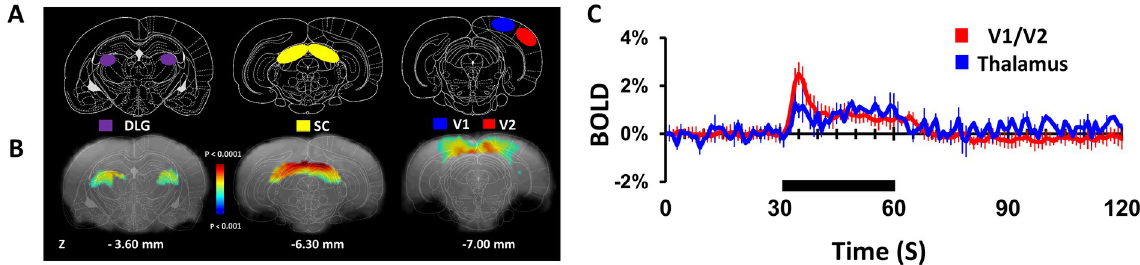
Fig 3. Visual stimulation-induced activation of rat visual cortex and thalamus revealed by high-field (11.7T) fMRI (8 rats, 21 trials). Significant BOLD activations were observed at the primary and secondary visual cortices (V1/V2), superior colliculus (SC) and thalamic activations were mainly found in dorsal parts of the lateral geniculate nucleus (DLG) during bilateral eye stimulation (1Hz, 50 ms, Blue light). BOLD activation maps, displayed as colored statistical maps (a 2-sample, unpaired, T-test with equal variance and one tail for stimulation (30s) > baseline (30s)) overlaid on the corresponding anatomical images. A and B represents coronal slices corresponding to visual cortices, superior colliculus (SC) and dorsal lateral geniculate nucleus (DLG) of the thalamus positioned at 7.0 mm posterior to bregma for V1/V2, 6.30 and 3.60 mm posterior to bregma for SC and DLG regions. To correlate activations in cortical and thalamic regions, reference stereotaxic atlas images were overlaid on the corresponding anatomical images. C represents the mean ± SD time course of BOLD activations at V1/V2 and DLG